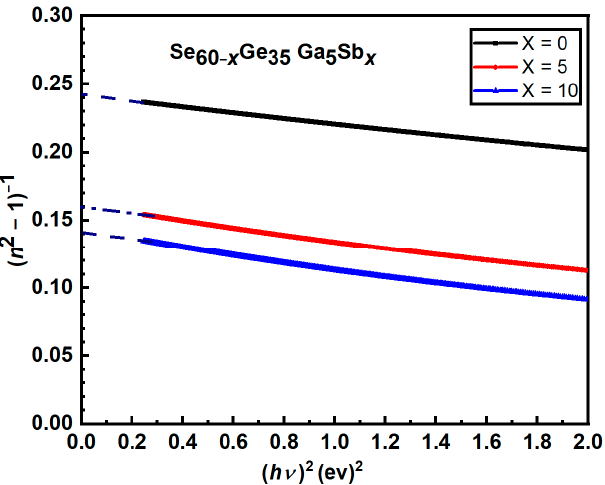
Figure 12. Plots of ( n 2 − 1) − 1 versus ( h υ ) 2 for Se 60 − x Ge 35 Ga 5 Sb x thin films. The authors apologize for any inconvenience caused and state that the scientific conclusions are unaffected.